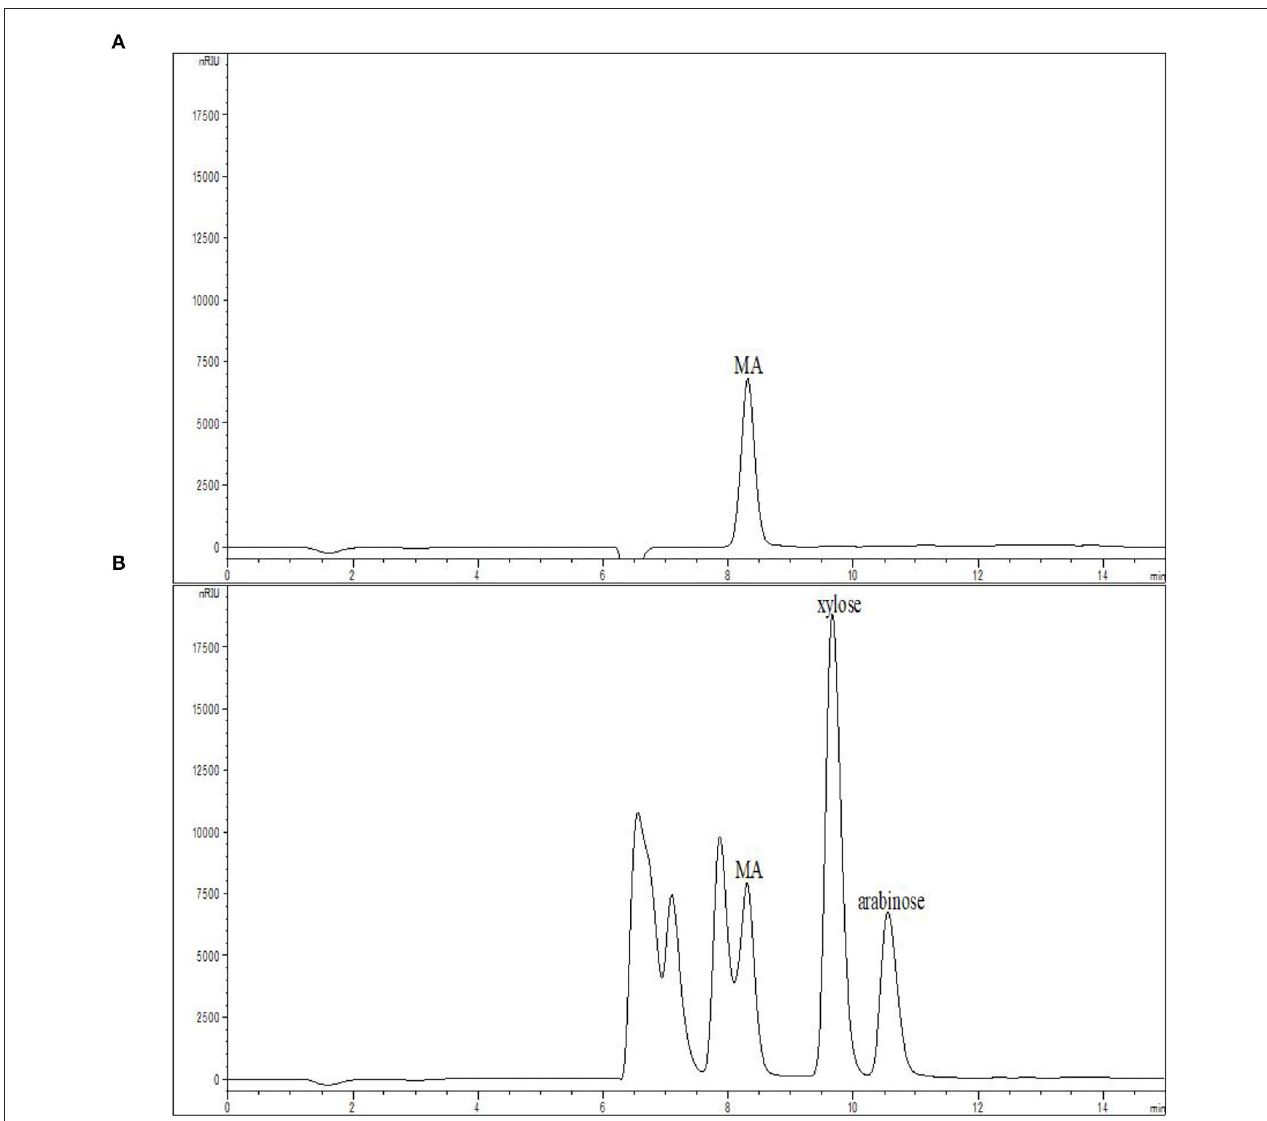
FIGURE 5 | MA solution chromatograms (A) prior to and (B) following xylan hydrolysis at 168 ◦ C with 0.08% MA for 15min. MA, maleic